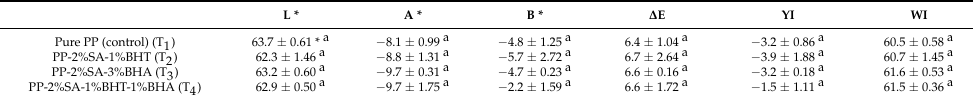
Table 4. Colour attributes of different polypropylene (PP)-based active